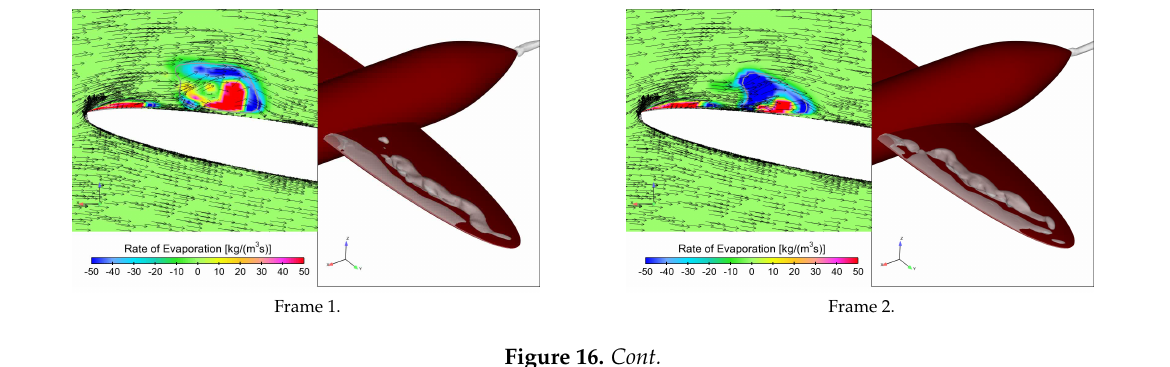
Figure 15. A sequence of snapshots visualizing one suction side sheet-cavitation shedding cycle. DDES on medium grid, σ = 0.53. Left frame depicts a cut plane of the left foil at mid-span, with velocity vectors denoted by arrows (only 25% of the velocity vectors is drawn on the plane for clarity), contour of the void fraction α = 0.1 denoted by the grey curves, and the plane is colored by the rate of evaporation. The right frame shows the cavity extent near the left foil by an iso-surface of α = 0.1. The frame number denotes the respective stage of the